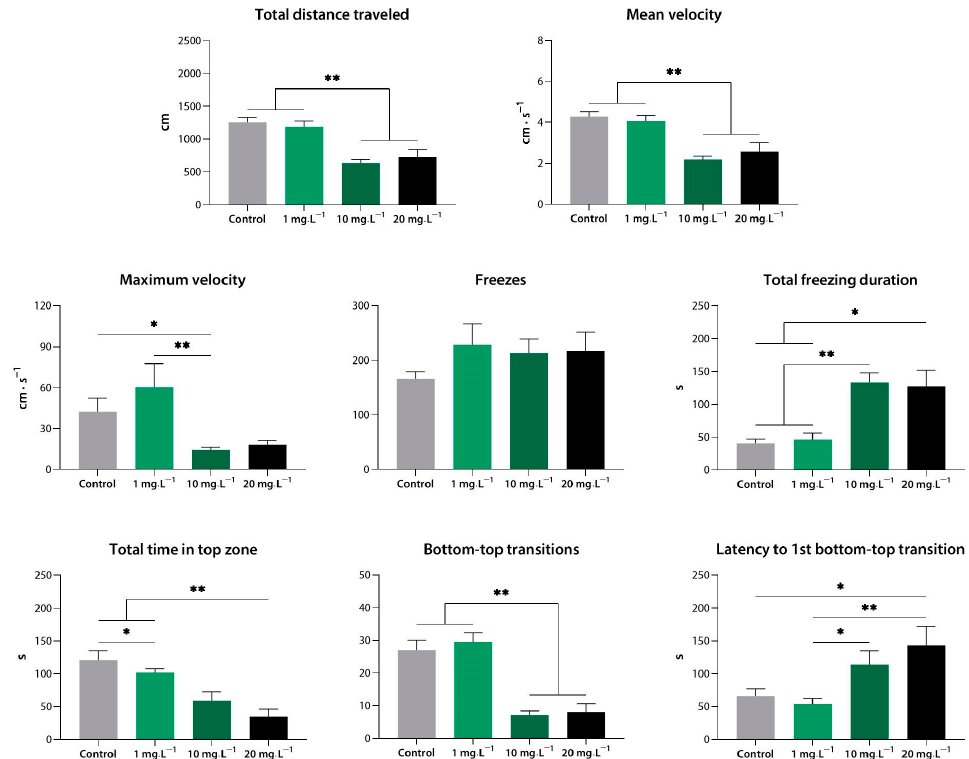
Figure 2. Compound 1 ( 9a ) induces sedation in zebrafish at a range of concentrations, as assessed using the novel tank test. *, p < 0.05; **, p < 0.01. 3.1.2. Sedative Activity of Compound 2 ( 9j ) in the Novel Tank Test Compound 2 at 100 mg·L − 1 markedly reduced the total distance covered, mean and maximum velocity, and total freezing duration ( p < 0.01 vs. control). At 10 mg·L − 1 , it also decreased the mean velocity of the zebrafish ( p < 0.01 vs. control). As with compound 1 , the concentration of 1 mg·L − 1 appeared to be too low to have detectable effects on zebrafish behavior in the NTT ( p < 0.05, p < 0.01 vs. 10 and 100 mg·L − 1 ) (Figure 3).